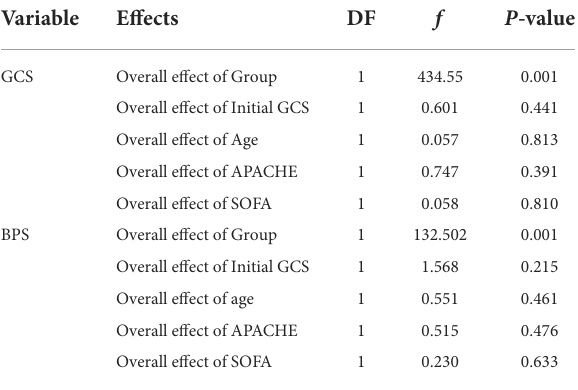
TABLE 4 Analysis of between-group effects for GCS and BPS score across the study groups. Variable